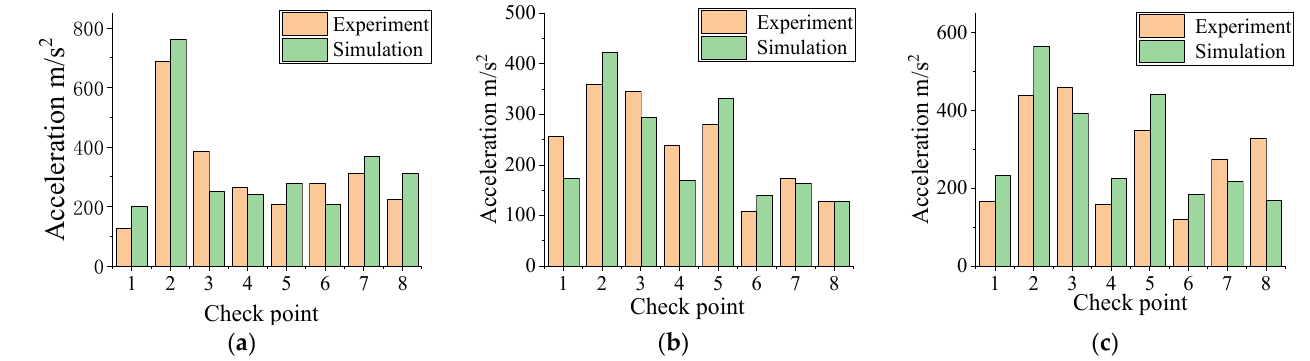
Figure 10. Comparison of acceleration response between transient analysis and test results. ( a ) 30 mm, 7 Hz; ( b ) 30 mm, 5 Hz ; ( c ) 40 mm, 5 Hz.